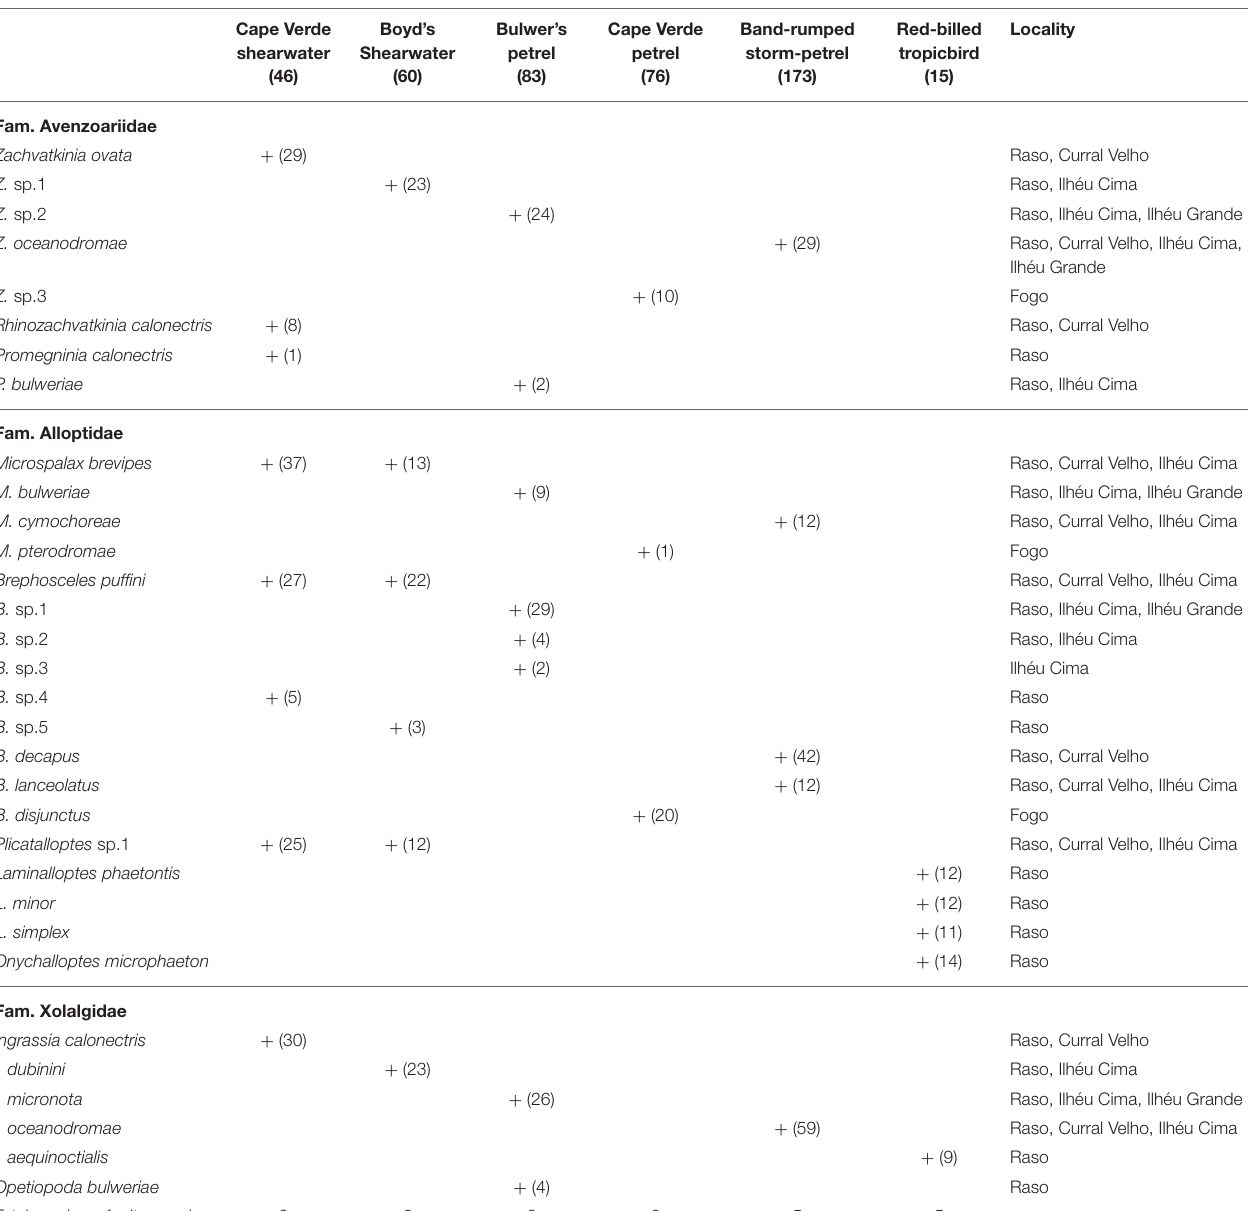
TABLE 3 | Feather mite richness for each seabird species breeding in the Cape Verde Islands.